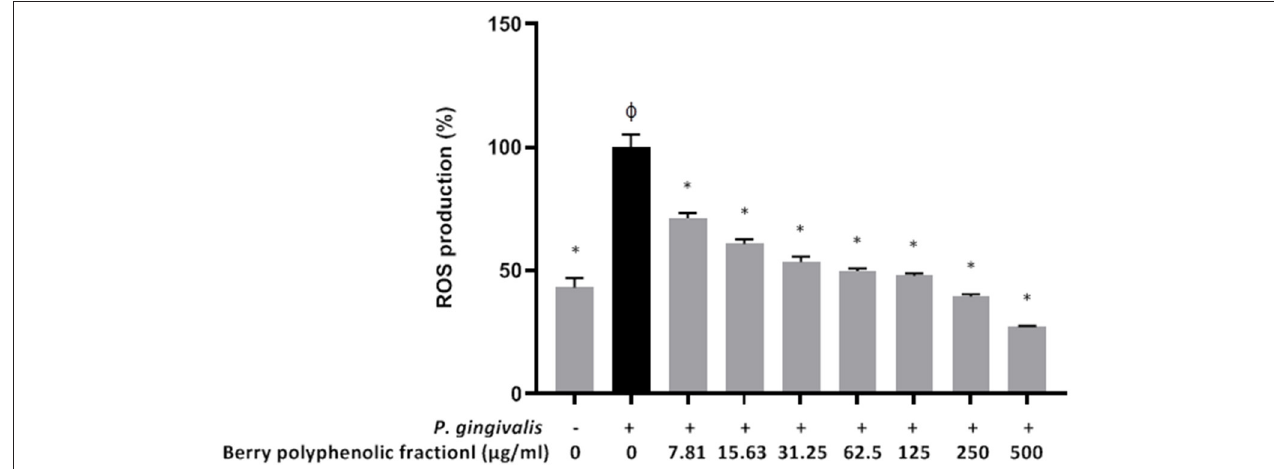
FIGURE 7 | Effect of the berry polyphenolic fraction on P. gingivalis -induced ROS production by oral keratinocytes. The + symbol indicates the presence of P. gingivalis at MOI of 10 3 . A relative value of 100% was assigned to ROS production in the absence of the berry polyphenolic fraction. Results are expressed as the means ± SD of triplicate assays from three independent experiments. ϕ Significant increase compared to the control (no P. gingivalis stimulation). *Significant inhibition ( p < 0.01) compared to the control (no fraction + P. gingivalis stimulation).